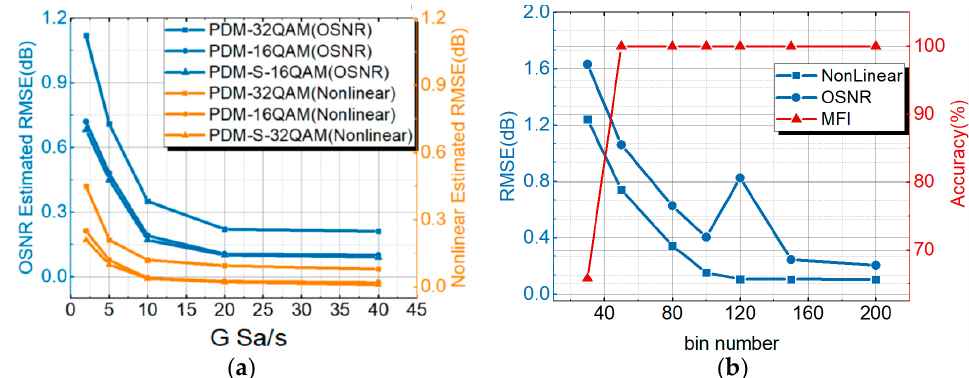
Figure 7. ( a ) RMSE of OSNR estimation and NL noise estimation with respect to the electronic sampling rate during the testing process for various modulation formats. ( b ) Trend of monitoring results (OSNR estimation, MFI and NL noise estimation) with the bin number of ACHs for PDM- 32QAM.